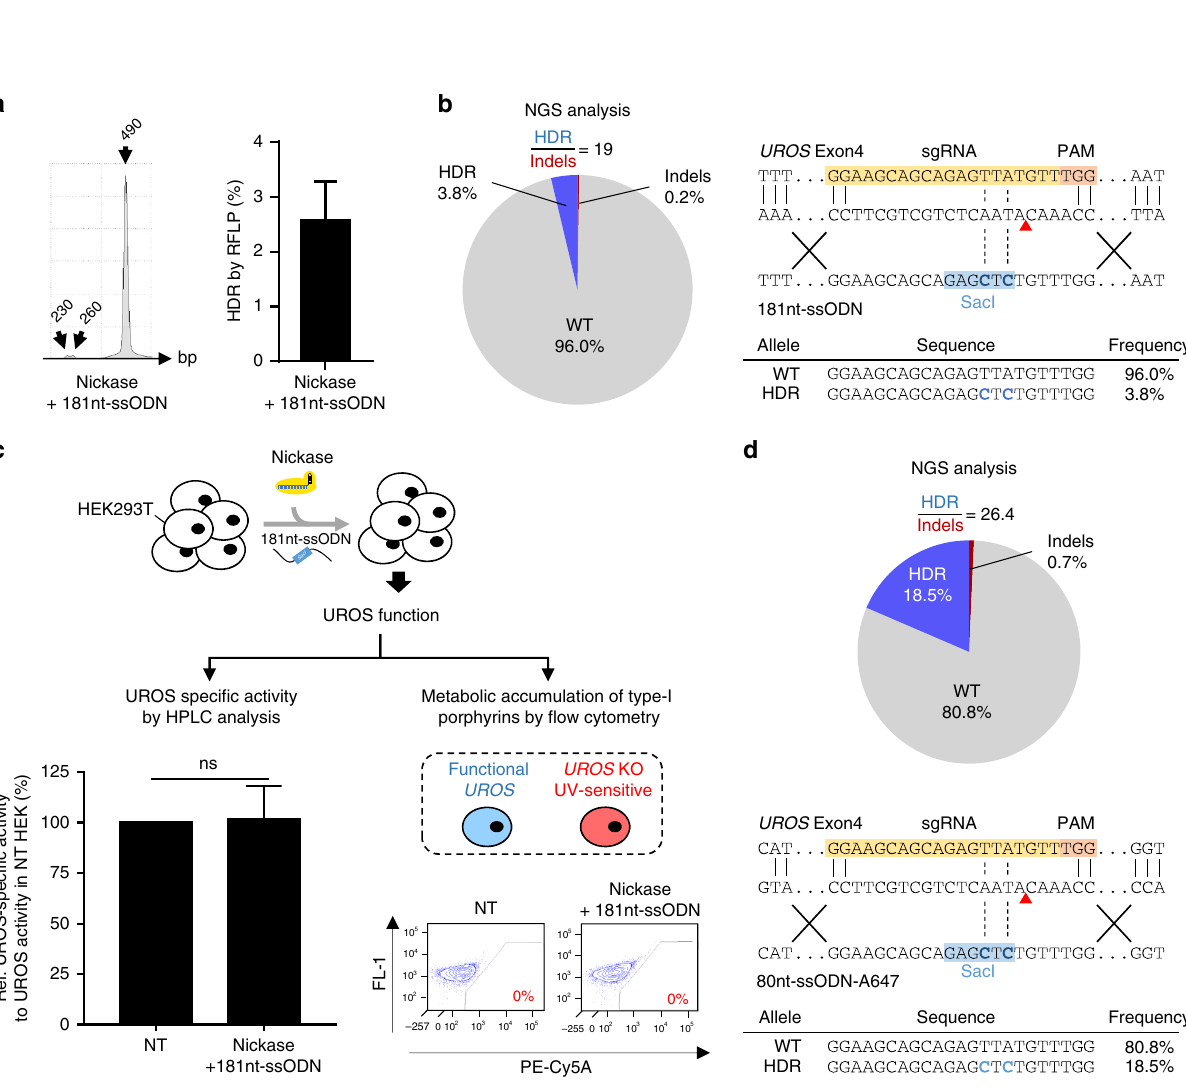
Fig. 4 Single nickase-mediated HDR is associated with minimal indels leading to preserved UROS functionality. a (Left) Illustrative RFLP analysis and (Right) HDR frequency for HEK293T cells transfected with nickase and a 181nt-ssODN ( n = 4). b (Left) NGS analysis of allelic outcomes and associated HDR/indel ratio following transfection of HEK293T cells with nickase and a 181nt-ssODN. (Right) Most common observed alleles (with frequencies ≥ 1%) aligned on the sgRNA sequence. HDR events in blue. c (Left) Quanti fi cation of UROS-speci fi c activity from NT HEK293T cells or transfected with nickase and a 181nt-ssODN ( n = 3). Values are normalized with NT cells. (Right) Illustrative fl ow cytometry results from NT cells or transfected with nickase and a 181nt-ssODN ( n = 3). d (Top) NGS analysis of allelic outcomes and associated HDR/indel ratio following transfection of HEK293T cells with nickase and optimized amount of a 80nt-ssODN-A647. (Bottom) Most common observed alleles (with frequencies ≥ 1%) aligned on the sgRNA sequence. HDR events in blue. Results are presented as mean ± SEM. Data are from independent experiments. Statistical signi fi cance is inferred on raw data using two-tailed unpaired t-test for UROS-speci fi c activity. ns, not signi fi cant. For ( a , c ), source data are provided